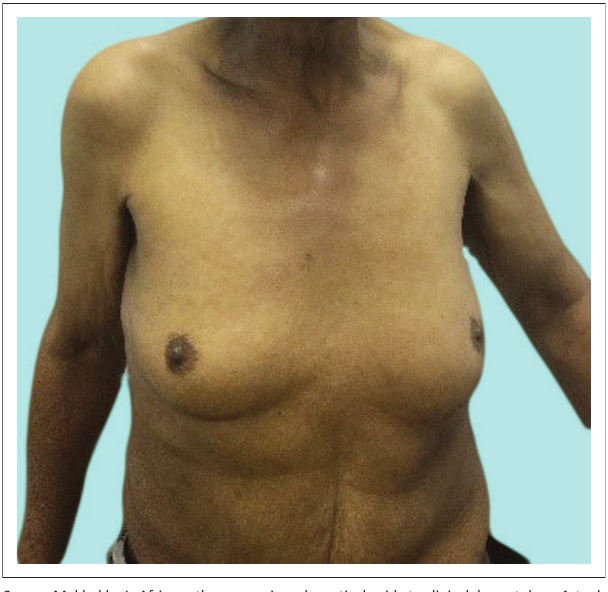
FIGURE 5: Ulcer on the left ear pinnae, typical area for M. leprae as it is cooler than the core body temperature.